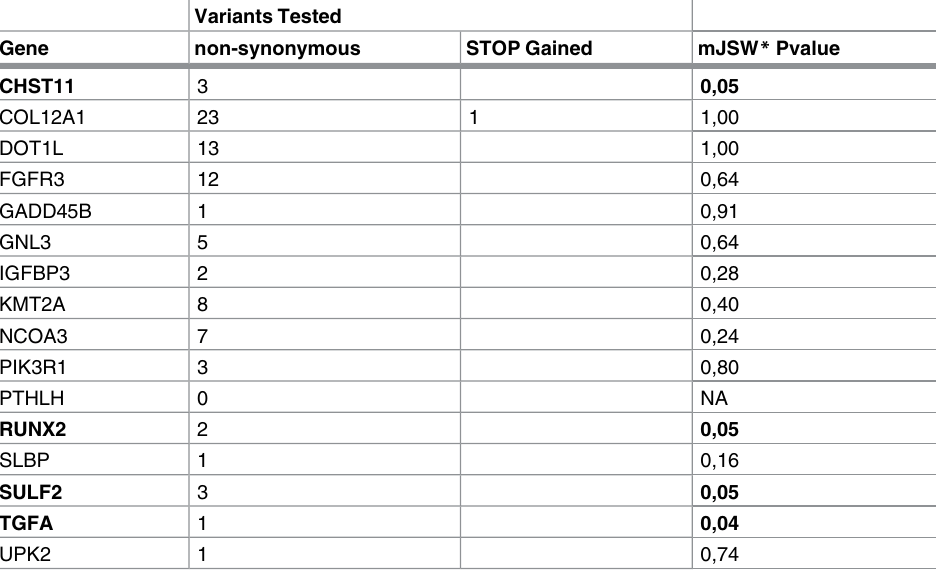
Table 5. Association between protein coding variants identified by exome-sequencing and mJSW. Variants